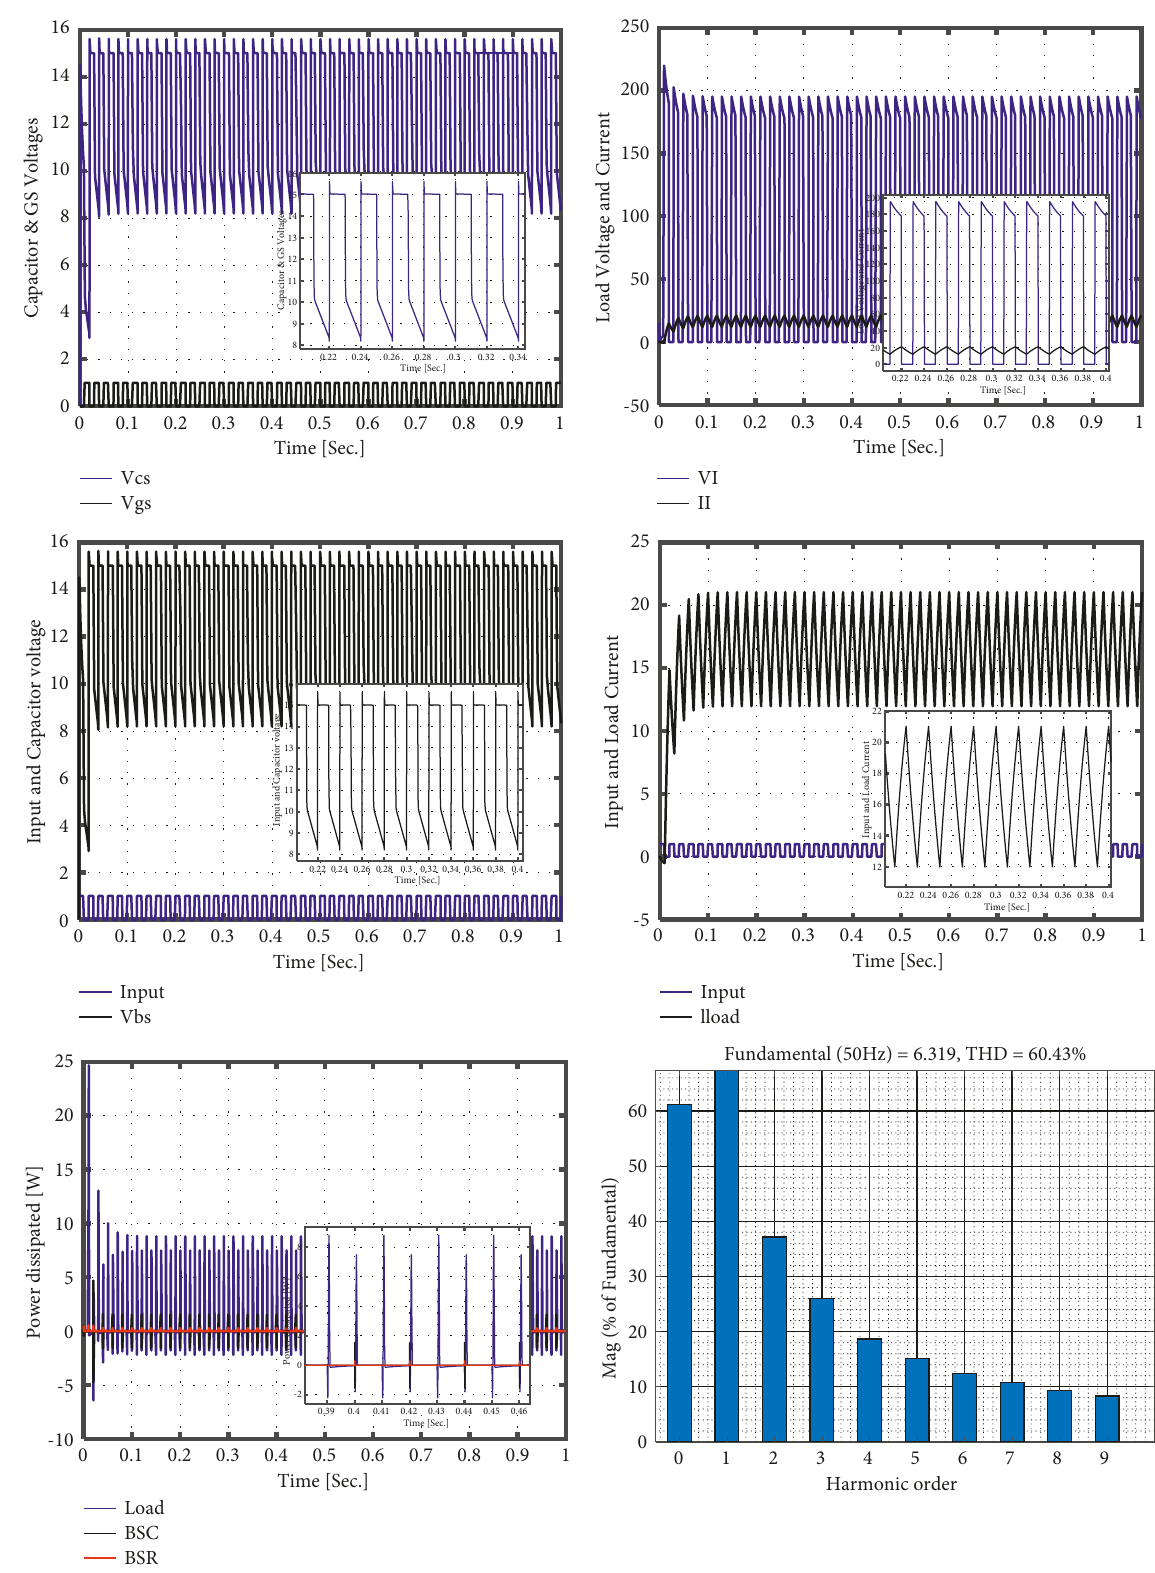
Figure 5: The system performance for a continuous current